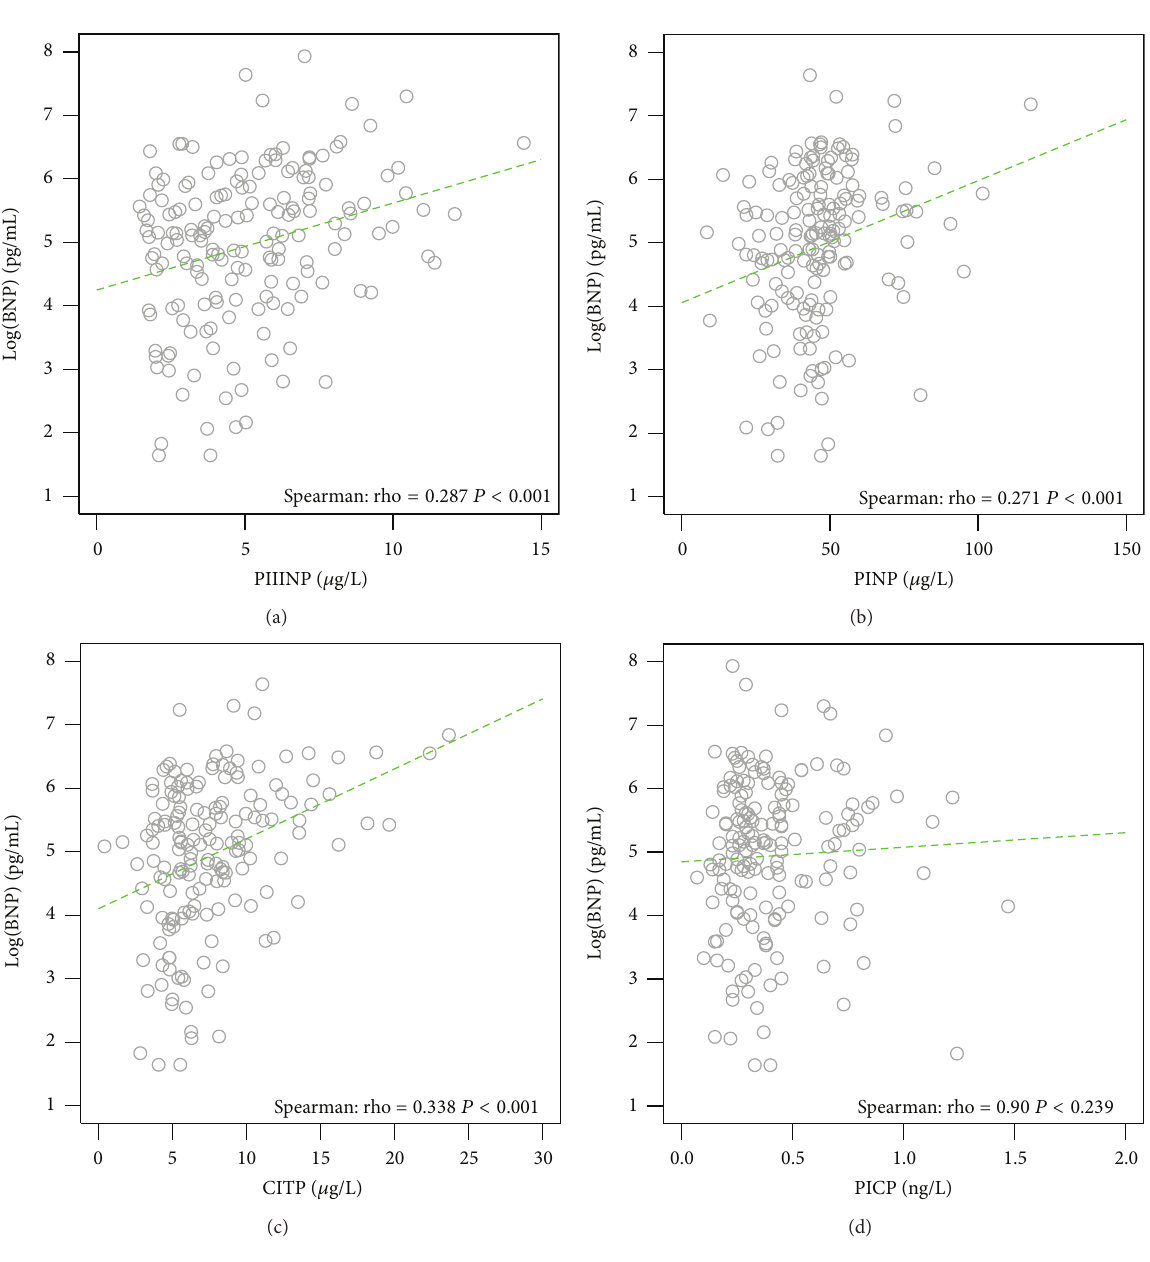
Figure 2: Correlation of collagen markers with